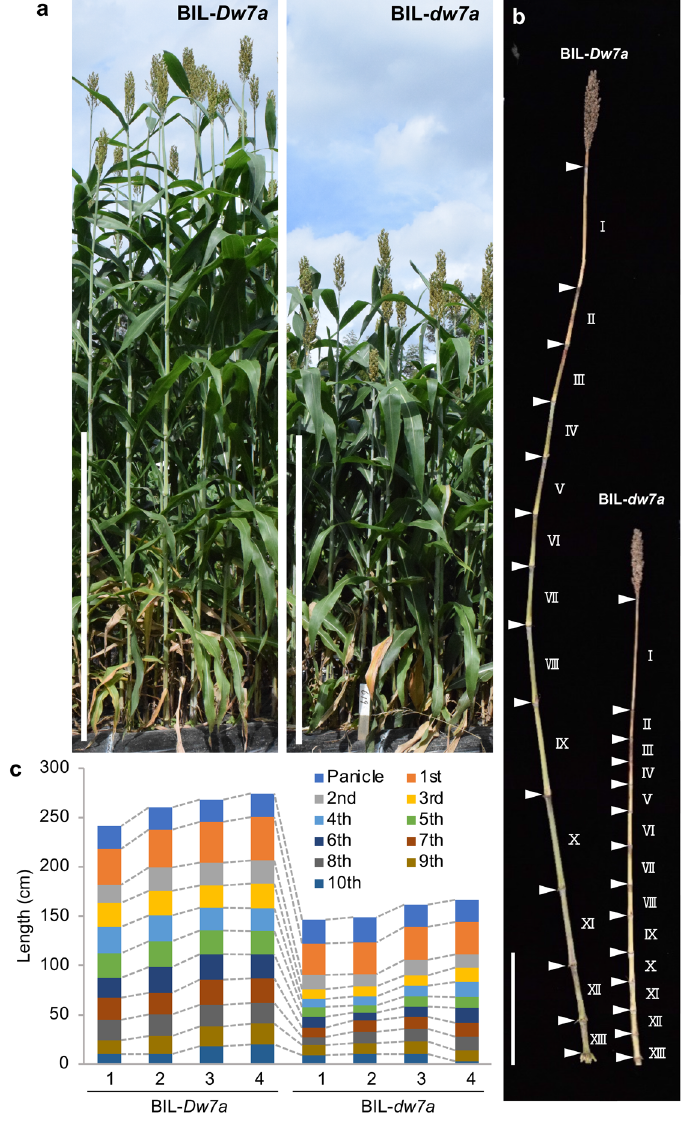
Figure 4. Plant stature and the elongation patterns of the BIL- Dw7a and BIL- dw7a internodes. ( a ) Plant stature of BIL- Dw7a and BIL- dw7a. Scale bars = 1 m. ( b , c ) Patterns of internode elongation. ( b ) Photograph of the internodes of BIL- Dw7a (left) and BIL -dw7a (right). The white arrowhead indicates the position of the node and the Roman numerals indicate the internode number. Scale bar = 30 cm. ( c ) The length of each internode of BIL- Dw7a and BIL -dw7a. Four representative plants are shown from each